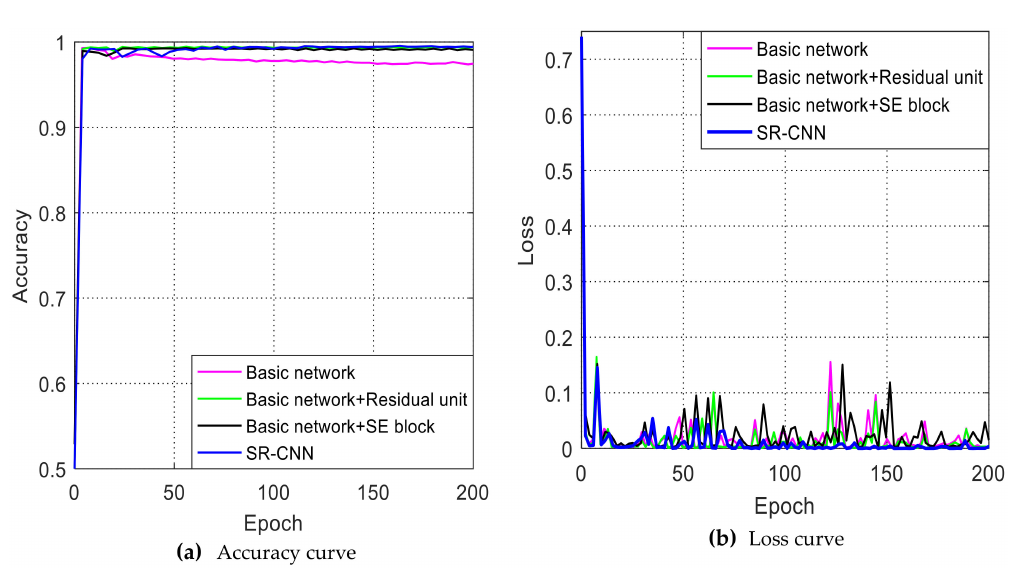
Figure 11. Accuracy and loss of different network architectures on dataset